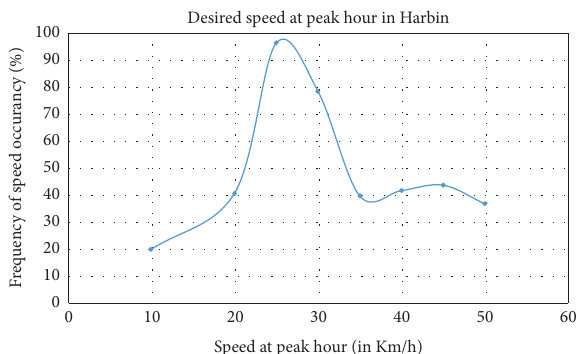
Figure 9: Desired speed at peak hour in